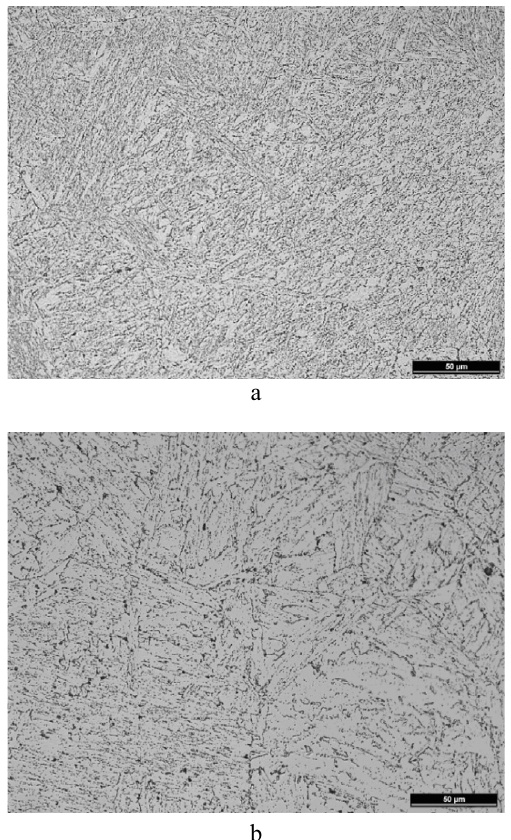
Fig. 6. Microstructure of steel P91 (the cross-section of the specimen): (a) in as-received state, (b) after exposure in impure helium 750 ° C/1000 h.